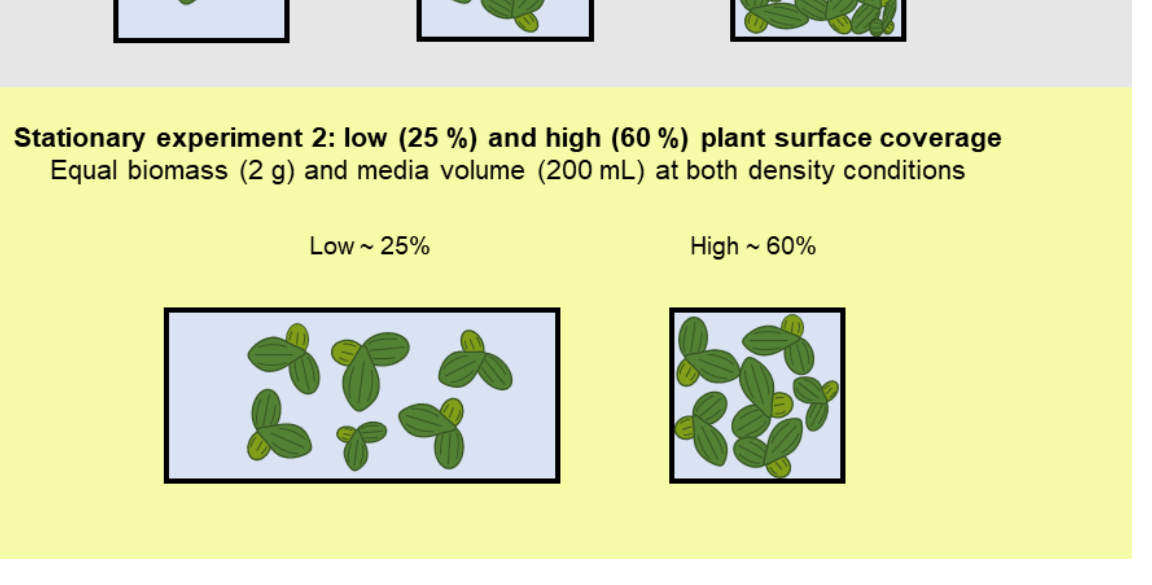
Figure 1. Set-up of stationary remediation experiments 1 and 2.